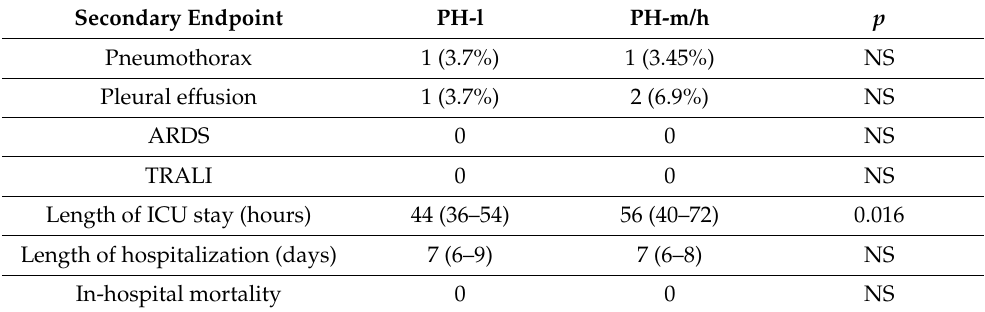
Table 8. Secondary endpoints in PH-m/h and PH-l groups.